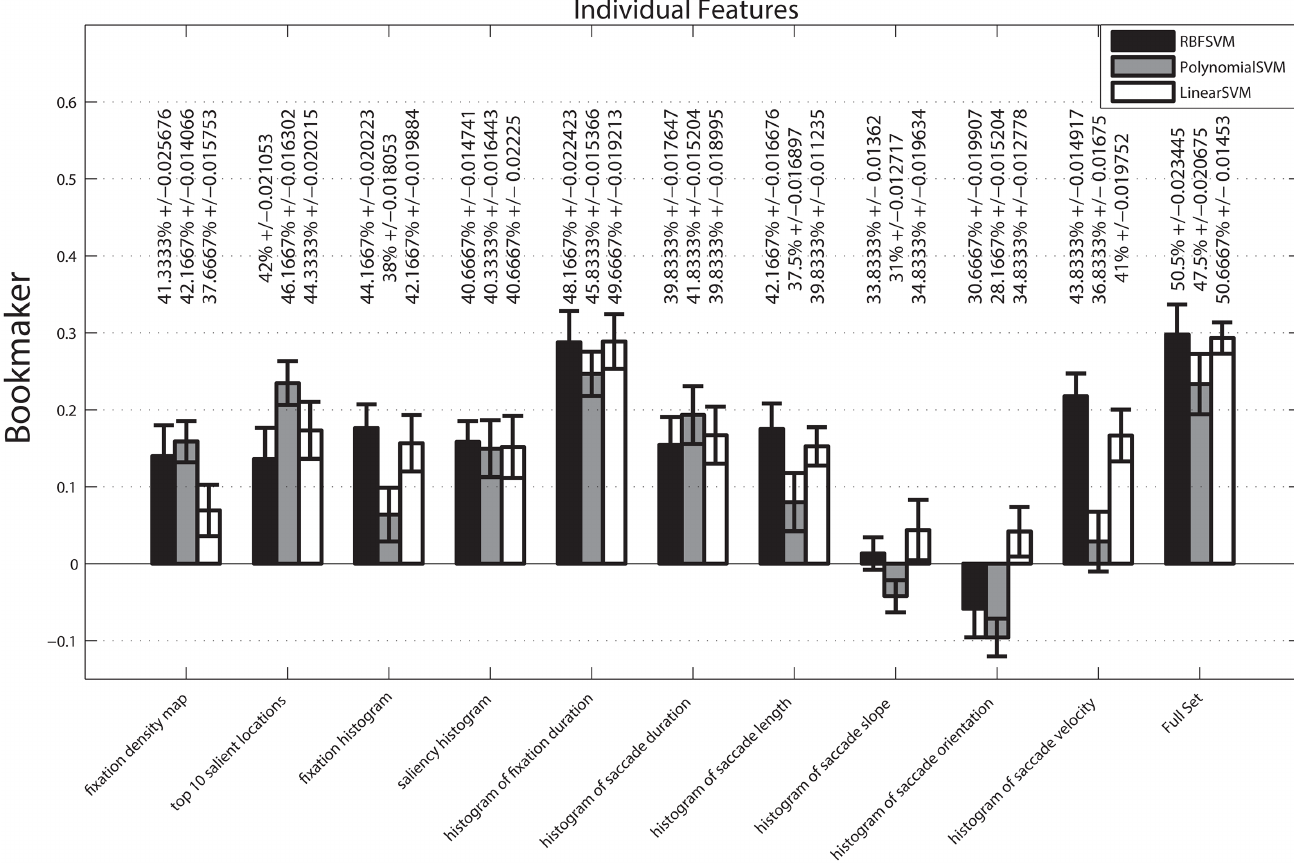
Fig 6. Baseline performance of individual histogram-based features in terms of bookmaker for classification of images into three class of unpleasant, neutral, and pleasant. The mean of classification accuracy across folds and repetitions (%) and their associated standard errors are added to each bar as a second measurement